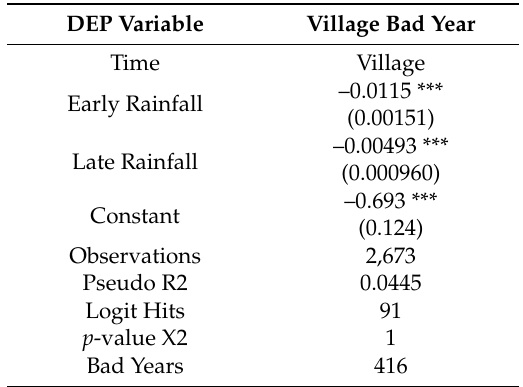
Table 3. Village level results from first visit (81